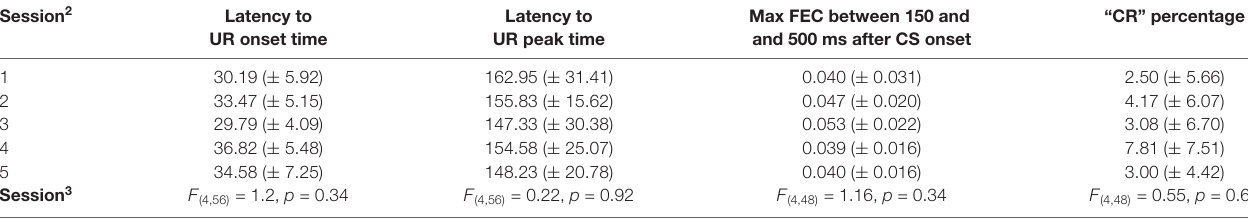
TABLE 2 | Average timing of unconditioned responses in US-only trials 1